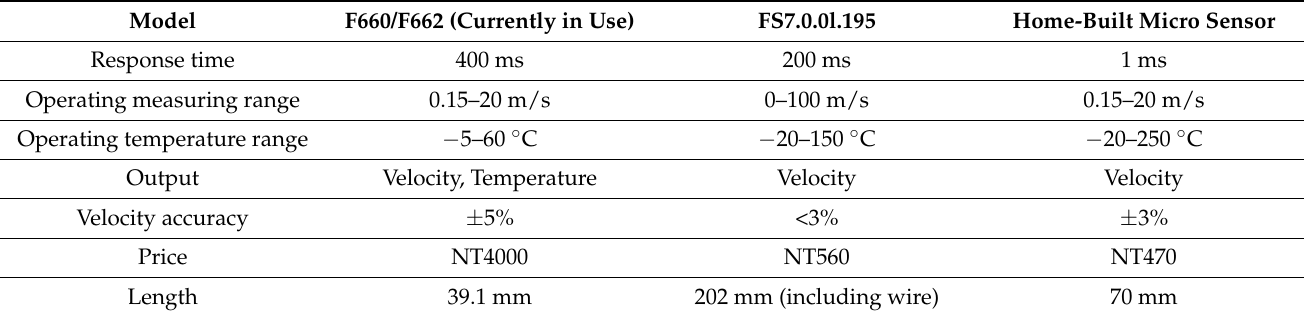
Table 1. Specification and performance comparison of two commercial air velocity sensors and the home ‐ built micro air velocity sensor. Figure 5. Commercial wireless air velocity sensors, ( a ) F660; and ( b ) FS7.0.1L.195.